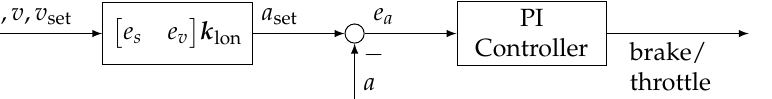
Figure 3. Longitudinal dynamics control structure consisting of an outer control loop that regulates spacing error e s and speed error e v as well as an inner loop regulating acceleration error e a